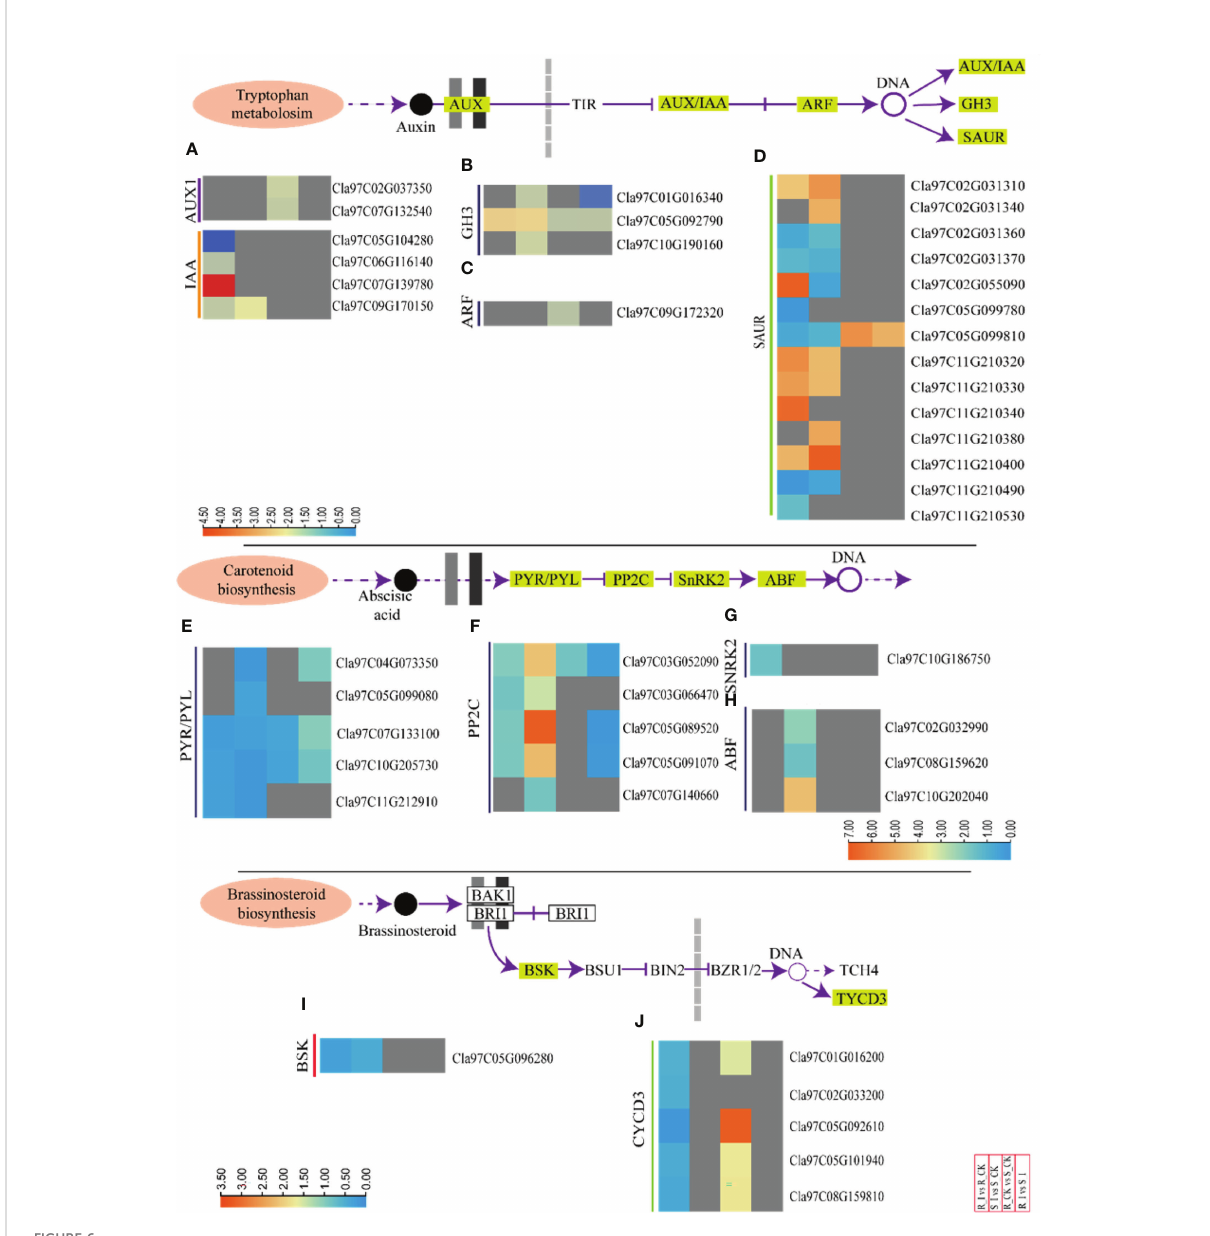
FIGURE 6 Transcriptomic analyses of incompatible and compatible interactions of the PM fungus in different watermelon lines. DEGs associated to auxin, abscisic acid and brassinosteriods from various combinations, such as groups R_I vs. R_CK, S_I vs. S_CK, R_CK vs. S_CK, and R_I vs. S_I, are presented in the form of a heatmap. The Log FC values corresponding to each gene in a group are used to generate a heatmap. The red and blue colours specify up-and down-regulated expressions. Genes related to IAA and AUX1 (A) , GH3 (B) , ARF (C) , and SAUR (D) , PYR/PYL (E) , PP2C (F) , SnRK2 (G) , ABF (H) , BSK and CYCD3 (I, J) are categorically shown in various combination groups. In the same way, heatmaps are used to show the genes of the abscisic acid (E – H) and brassinosteroid (I, J) biosynthesis